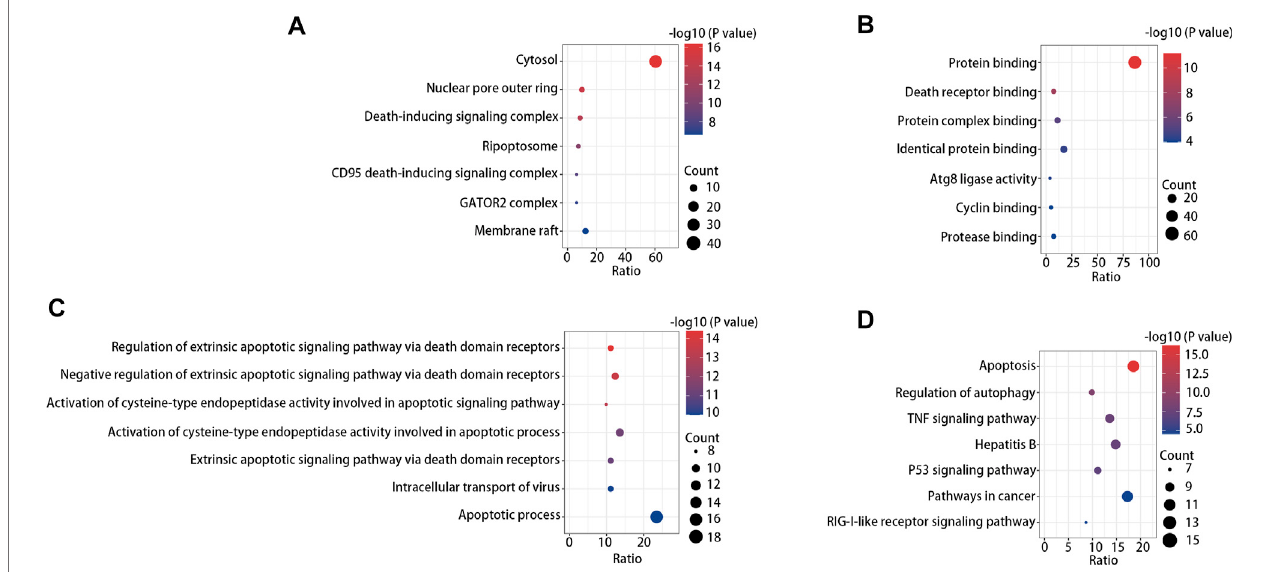
FIGURE 5 | GO enrichment analysis result of cellular component, (A) molecular function, (B) and biological process (C) . (D) Top seven enriched KEGG pathway distribution.